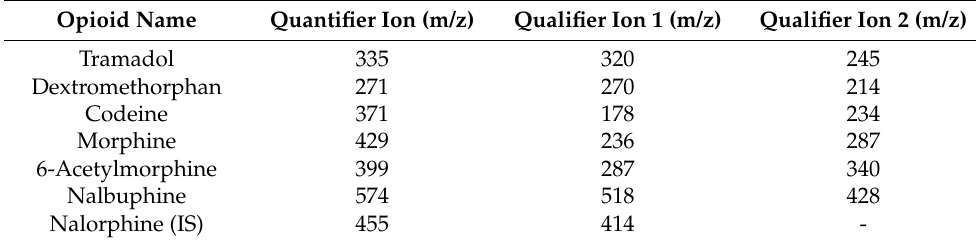
Table 2. Target opioids with their respective SIM ion.